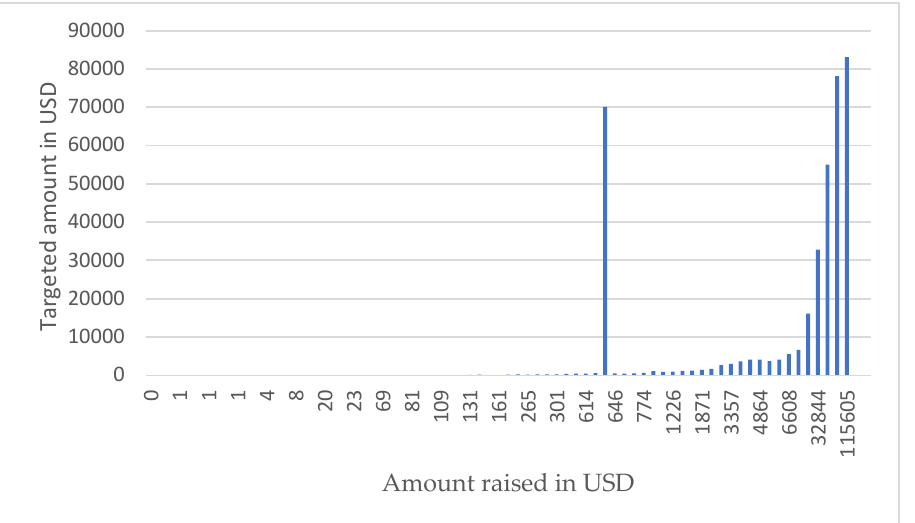
Figure 4. Total amount raised. Source: Authors’ own compilation.